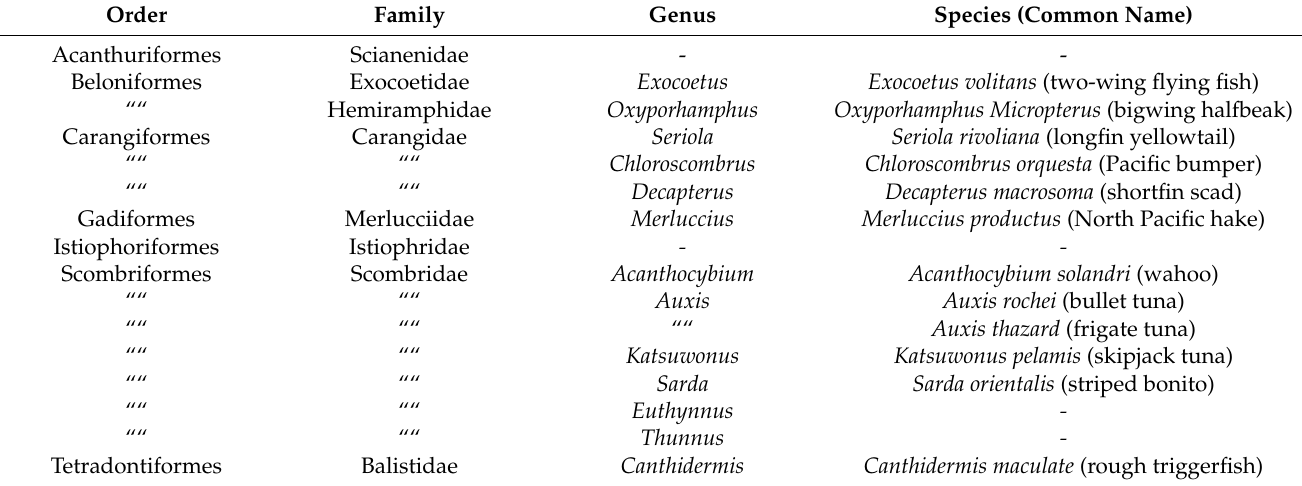
Table 1. Taxonomic classification of amplicon sequence variants (ASVs) across all sampled fishing vessels. ““ indicates same taxonomic level as above cell. -indicates no data.